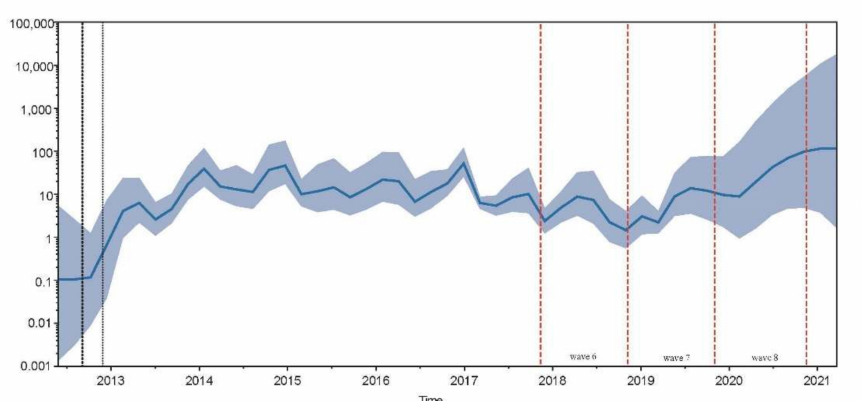
Figure 4. The population size of H7N9. The solid blue curve stands for the median value of the viral population. The blue colored area corresponds to the credibility interval based on 95% highest posterior density (HPD).